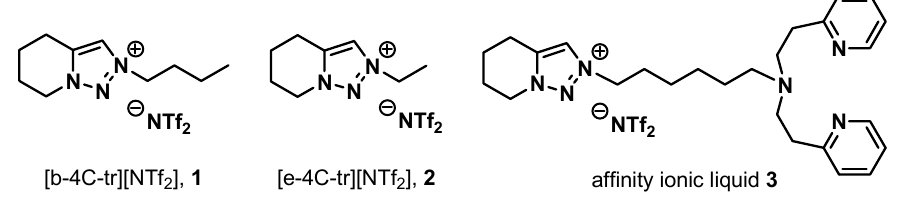
Figure 1. Structures of [b-4C-tr][NTf 2 ] 1 , [e-4C-tr][NTf 2 ] 2 and affinity ionic liquid 3 .